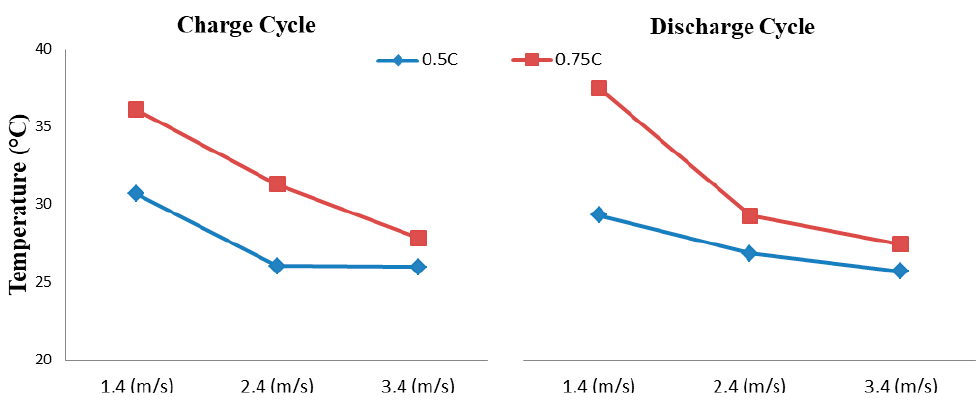
Figure 16. Effects of air increasing air flow rate on maximum temperature. Figure 16. E ff ects of air increasing air flow rate on maximum